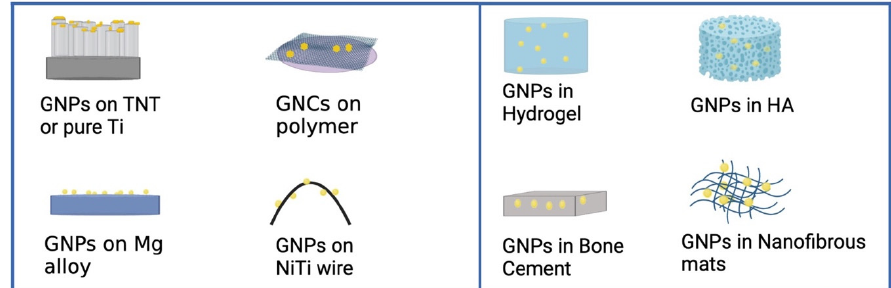
Figure 3. The locations of gold nanoparticles after implant material modification.